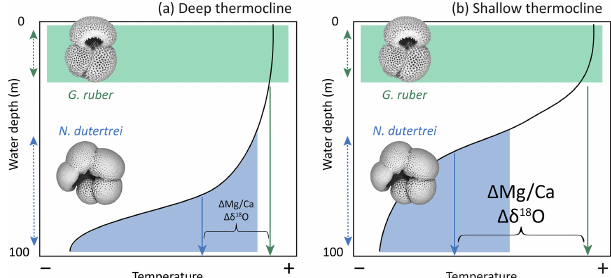
Figure 3. Conceptual manifestation of the thermocline depth as a (cid:49) Mg / Ca (cid:49)δ 18 O signal. Depth differentiation of the G. ruber and N. dutertrei habitats (stippled arrows) on a vertical temper- ature gradient (black line) sets a δ 18 O and Mg / Ca offset in ex- ported foraminiferal tests (solid arrows). The magnitude of this off- set changes in response to thermocline shoaling and